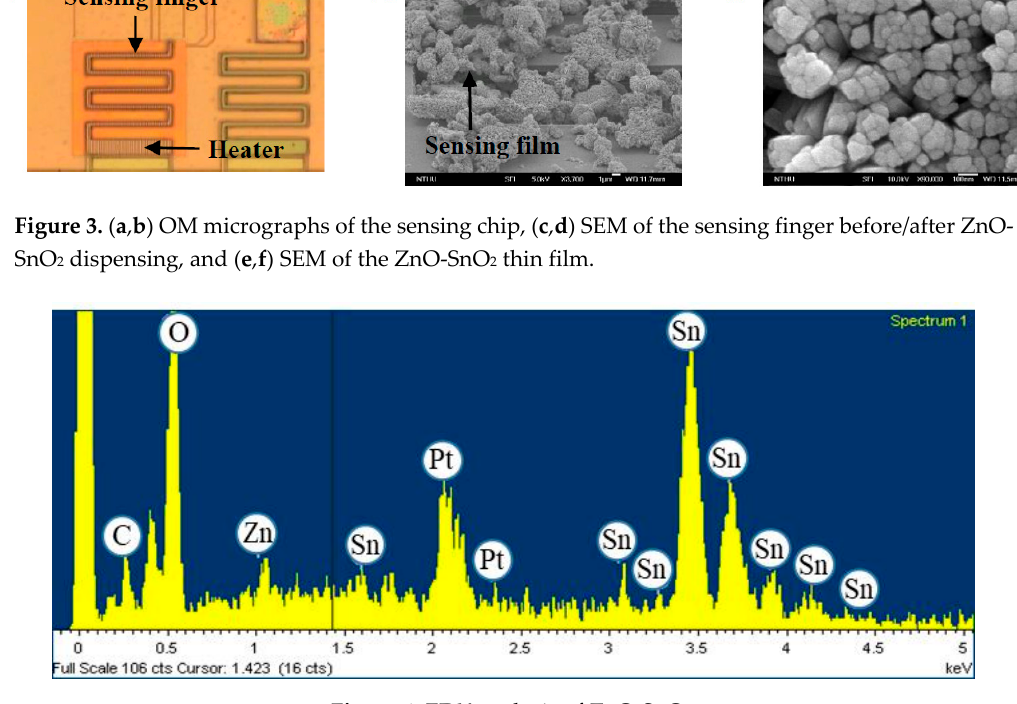
Figure 4. EDX analysis of ZnO-SnO 2